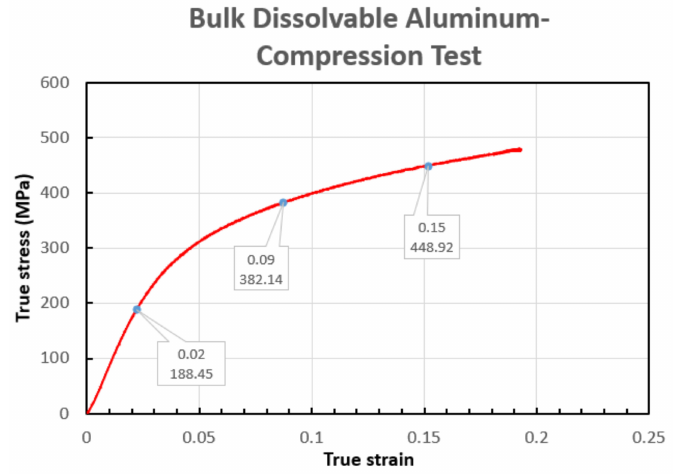
Figure 9. The experimental result of compression bulk dissolvable aluminum cube with three unique points marked out with true stress and true strain.